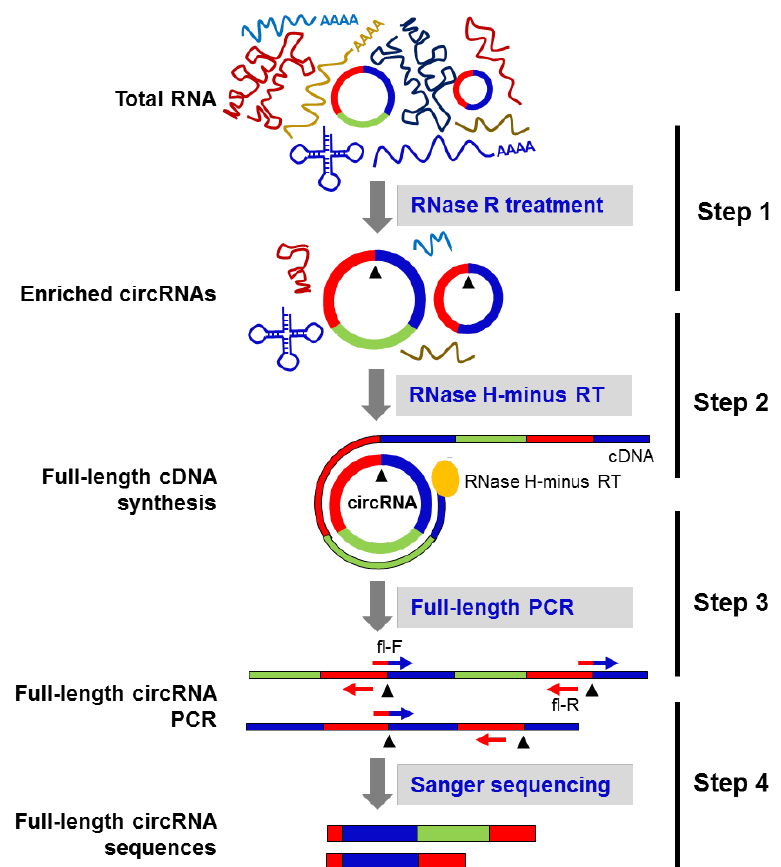
Figure 2. Schematic of the circRNA-Rolling Circle Amplification (circRNA-RCA) method. Step 1: total RNA is digested with RNase R to enrich the circRNA population. Step 2: the enriched circRNA pool is reverse-transcribed with RNase H-minus reverse transcriptase. Step 3: cDNA prepared in the above step is amplified by PCR, using full-length primers. Step 4: Sanger sequencing of the full-length circRNA PCR products identifies the mature spliced sequence of circRNAs and their splice variants. Black arrowheads represent the backsplice site.